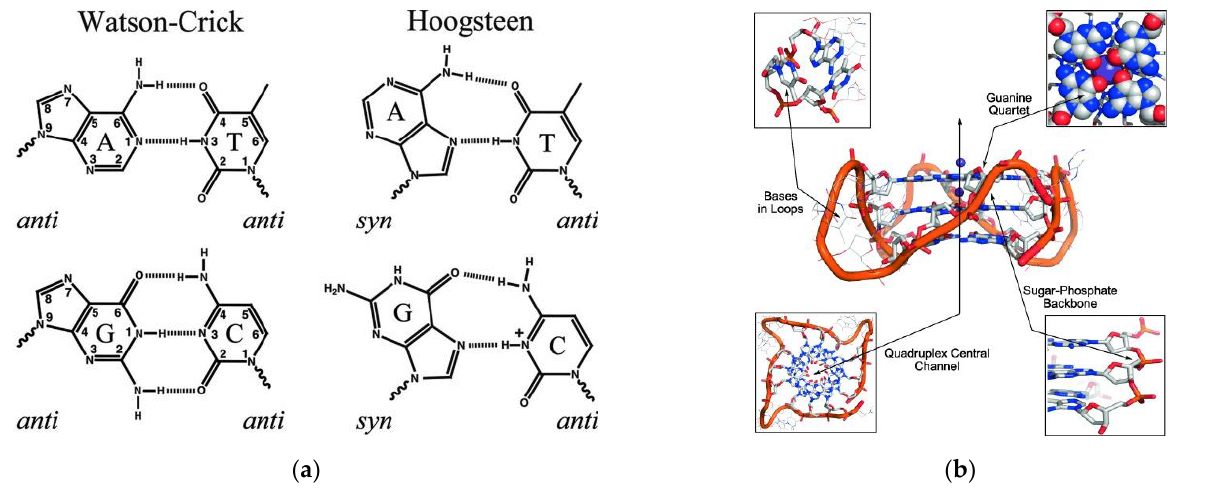
Figure 5. ( a ) Base-pair interactions. Reprinted with permission from Ref. [96] . Copyright (2013) Wiley Periodicals, Inc; ( b ) structural features and targeted sites of a G-quadruplex. Reprinted with permission from Ref. [97] . Copyright (2010) Wiley — VCH Verlag GmbH & Co. KGaA, Weinheim.